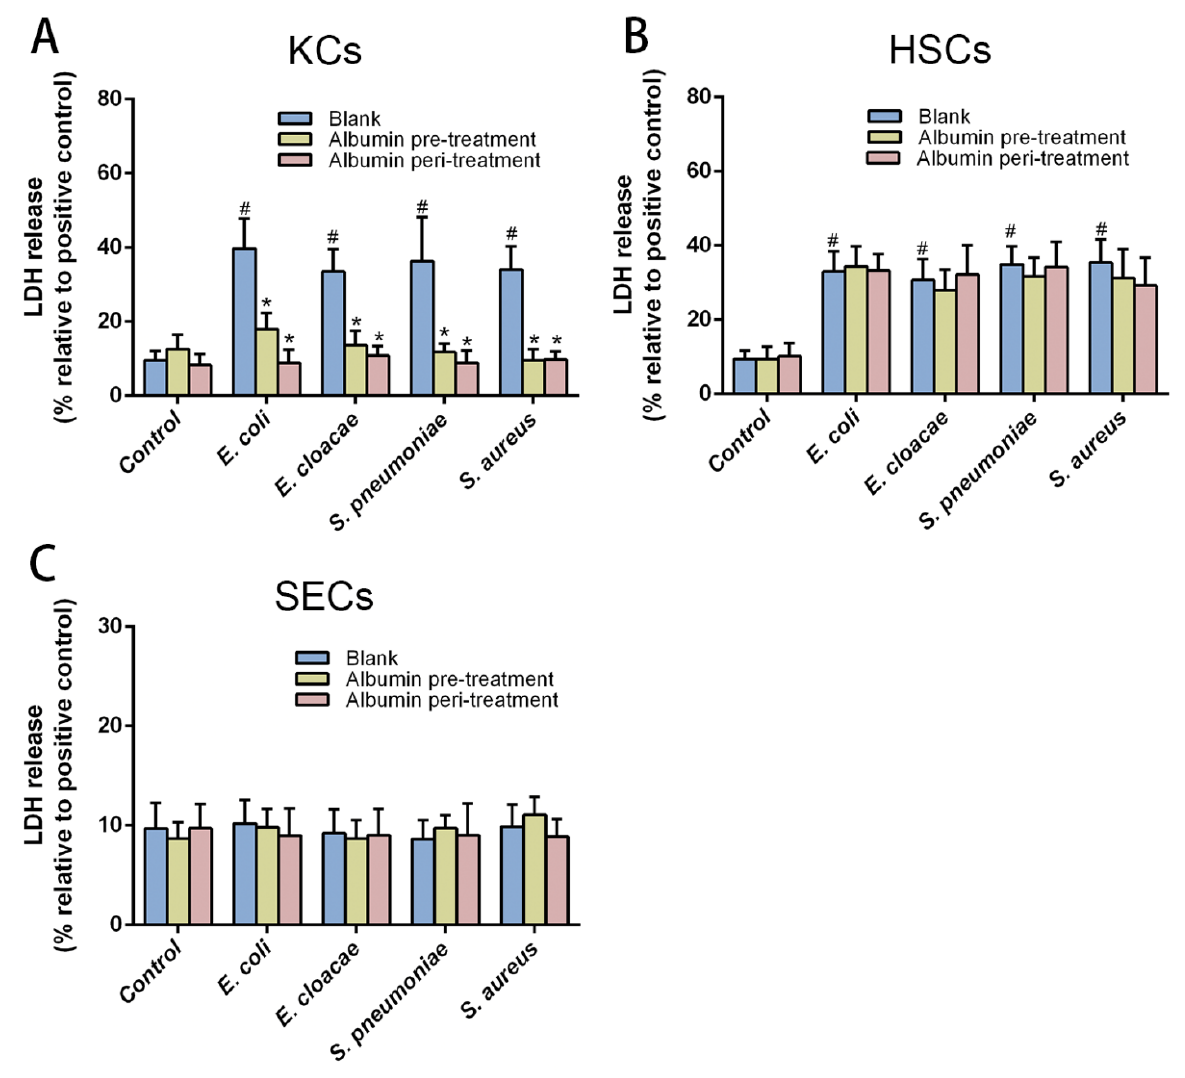
Figure 3. Different effects of albumin on different hepatic non-parenchymal cells. ( A ) Effects of albumin (0.4 mg/mL) on the cell damage induced by bacterial products (8 µ g/mL) for KCs. No significant effects of albumin on HSCs ( B ) and SECs ( C ) were found in both pre-treatment and peri-treatment. Data expressed as means ± SD, * p < 0.05 vs. blank treatment in their own group, # p < 0.05 vs. blank treatment in the control group, n = 6 in each group from three independent experiments with a total of three different human livers.